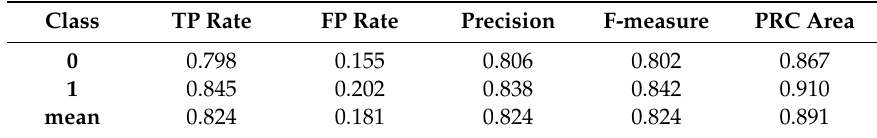
Table 2. Predictive performances reached by the model for the mutagenicity (0 and 1 indicate non-permeant and permeant molecules,